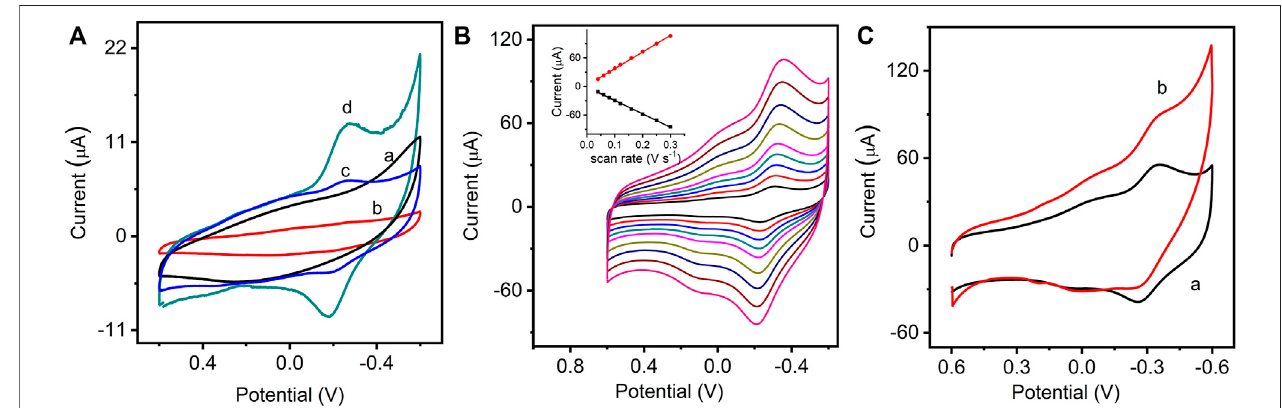
FIGURE 2 | (A) Cyclic voltammograms (CVs) of GO/glassy carbon electrode (GCE) (a), NMB/GCE (b), GO/NMB/GCE (GO and NMB physical mixture) (c), and GO – NMB/GCE (d) in 0.1 M phosphate buffer solution (PBS) (pH 7.0, 0.10 V s − 1 ). (B) CVs of GO – NMB/GCE at different scan rates of 0.04, 0.06, 0.08, 0.10, 0.12, 0.16, 0.20, 0.25, and 0.30 V s − 1 (inset: the relationship between the redox peak current and the square root of the scan rate). (C) CVs of GO – NMB/GCE in 0.1 M PBS in the absence (curve a) and presence (curve b) of hydrogen peroxide (H 2 O 2